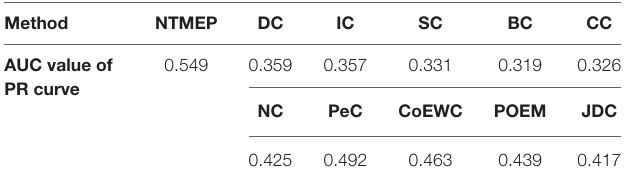
TABLE 2 | The AUC values of the PR curve obtained from NTMEP and other 10 competitive